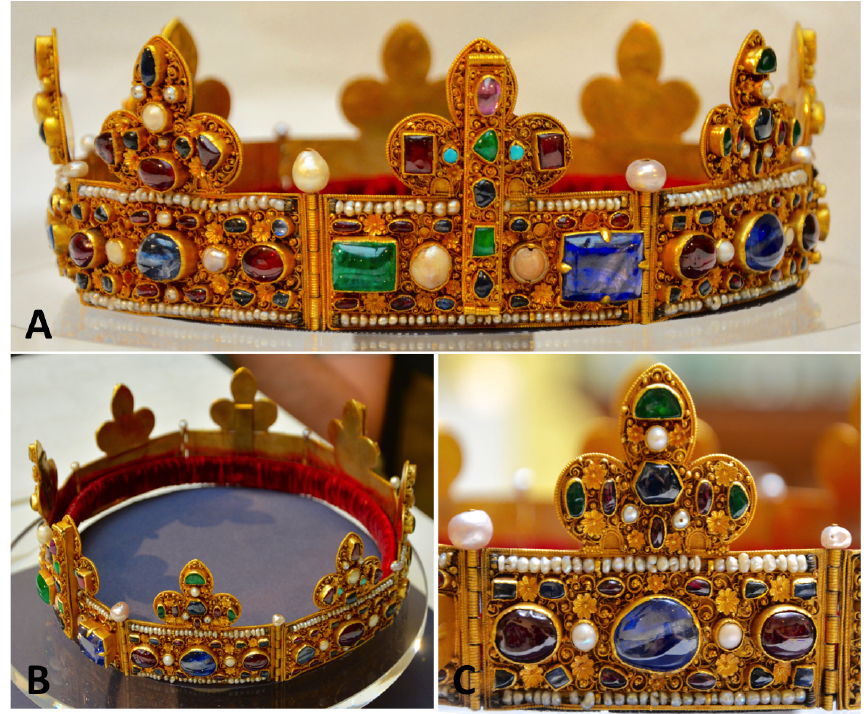
Figure 1. Photographs of the reliquary crown of Namur (© Frédéric Hatert). (a) Front view. (b) Top view. (c) Close up of the p6 gold